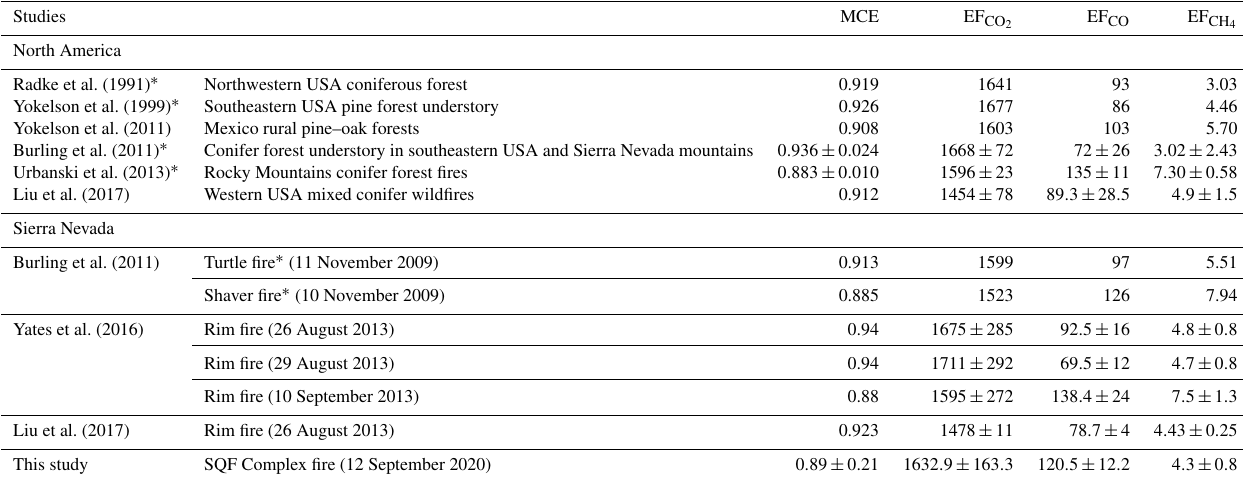
Figure 4. (a) Time series of coinciding EM27/SUN 30min average observation period with a TROPOMI overpass with a 15km radius. (b) Correlation between coinciding TROPOMI and EM27/SUN data pairs. The error bars are the standard deviation of the TROPOMI- averaged pixels at 15km and the EM27/SUN 30min observation. Table 2. Summary from past airborne studies and the present study of modified combustion efficiency (MCE) and emission factors (EFs;